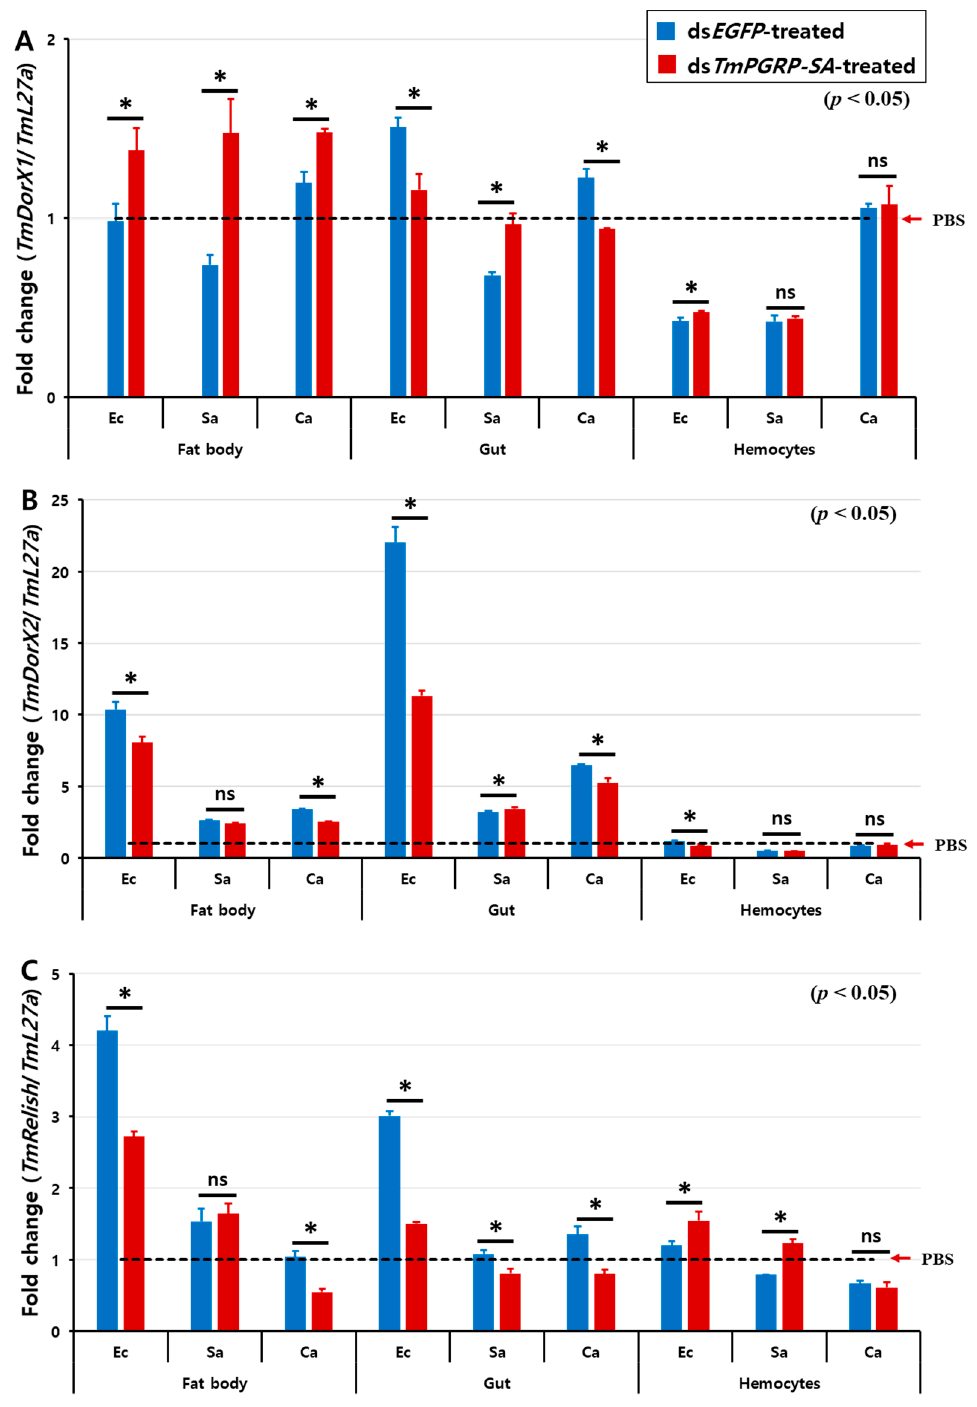
Figure 8. Relative transcript level of three NF- κ B transcription factors in TmPGRP-SA knockdown insects following microbial infection. The average fold-change of TmRelish ( A ), TmDorX1 ( B ), and TmDorX2 ( C ) in TmPGRP-SA -silenced larvae following challenge with E. coli (Ec), S. aureus (Sa), and C. albicans (Ca) was quantified relative to that of L27a at 24 h post-challenge. ds EGFP served as a negative control. Bars represent mean ± SE of three independent experiments. ‘*’ indicates significant difference ( p < 0.05); ns = not significant.